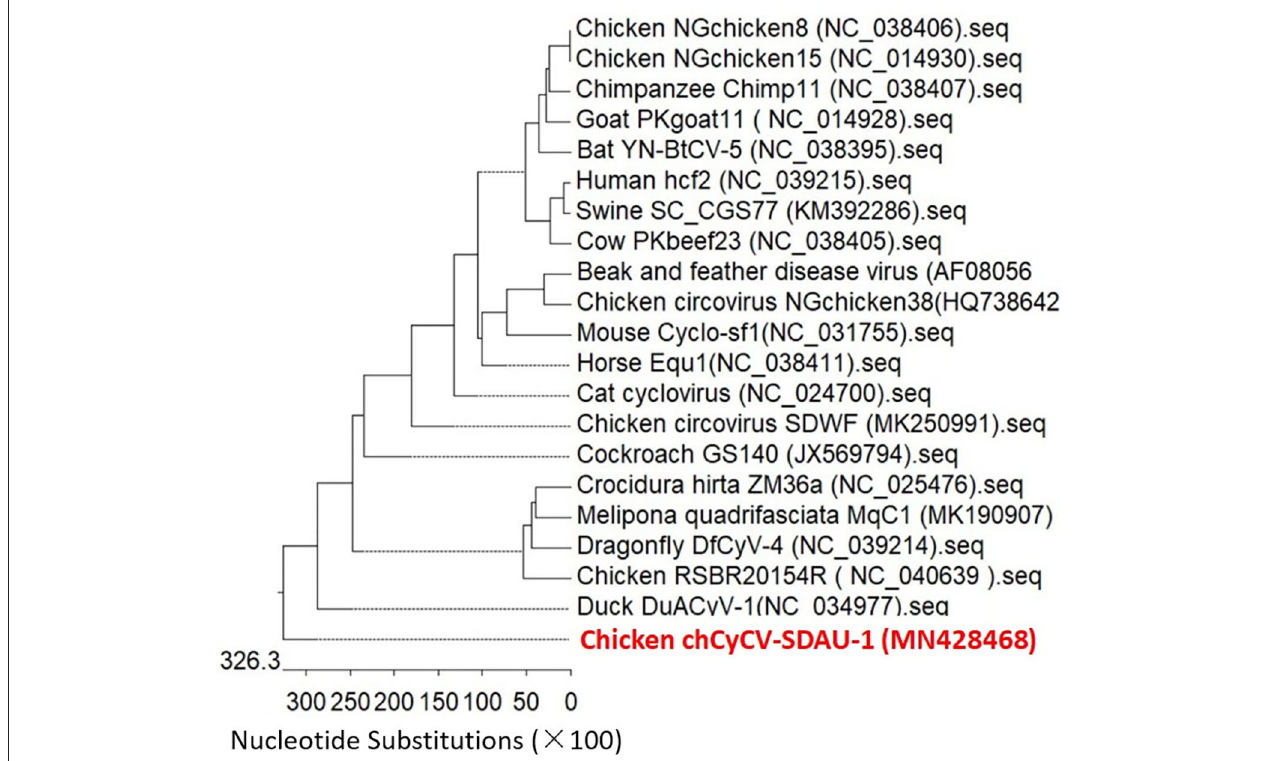
FIGURE 2 | chCyCV-SDAU-1 gene structure. CyCV-SDAU-1 containing two major ORFs of the Rep and Cp proteins and two